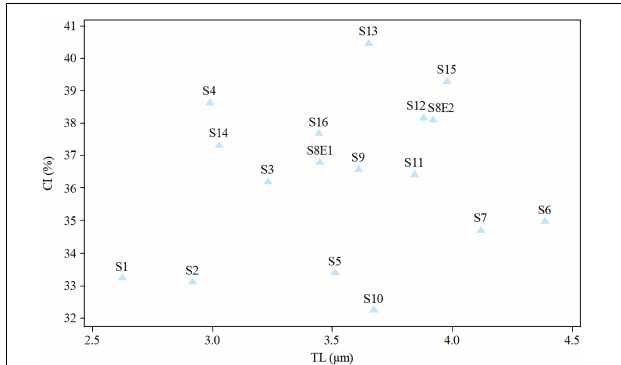
FIGURE 8 | Relationship between the total length of haploid complement (TL) and centromeric index (CI) of 17 Pimpinella populations of 17 species.